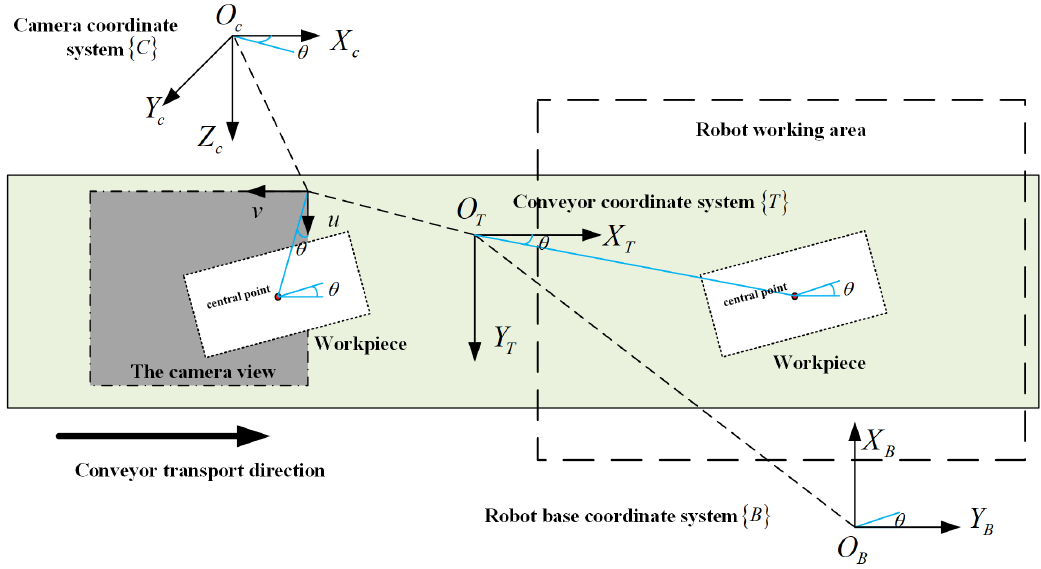
Figure 5. Relative relations between coordinate